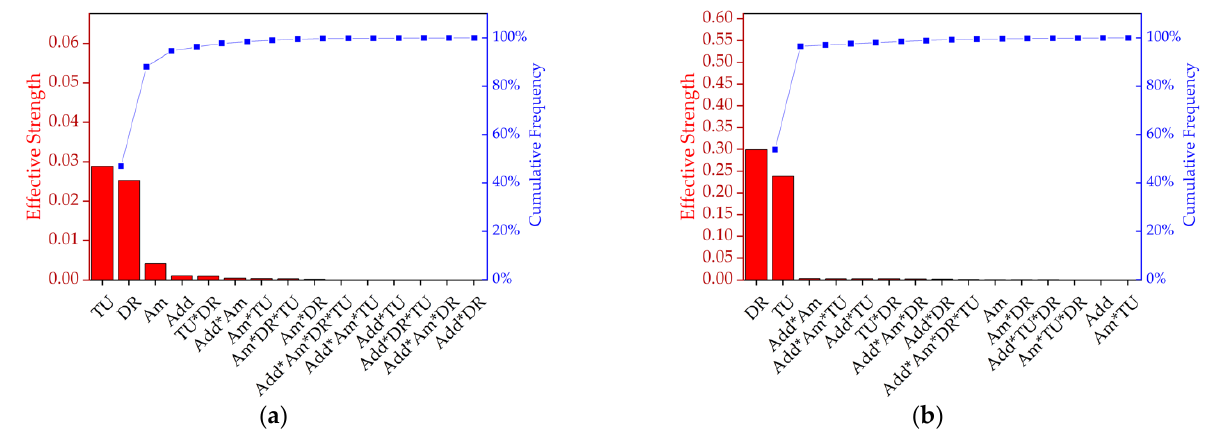
Figure 5. Pareto chart ranking the effective strength and cumulative frequency of the factors and the interactions that influence ( a ) tenacity and ( b ) elongation. DR = draw ratio, TU = take-up velocity, Add = nucleating agent additive, and Am = amount of nucleating agent. Table 2. Significance level (p) of factors and their interactions corresponding to Figure 5.